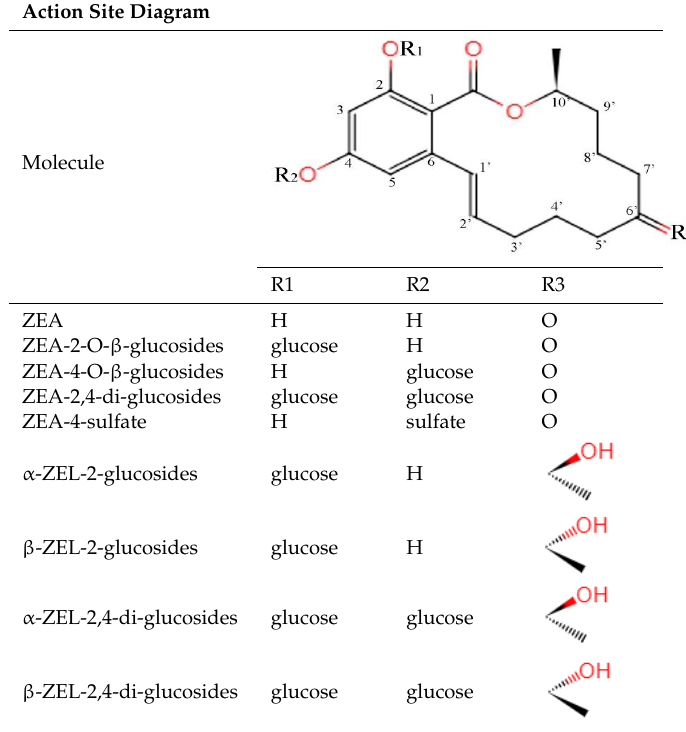
Table 2. The structure of ZEA and its phenol hydroxy (C 2 /C 4 -OH) derivatives.